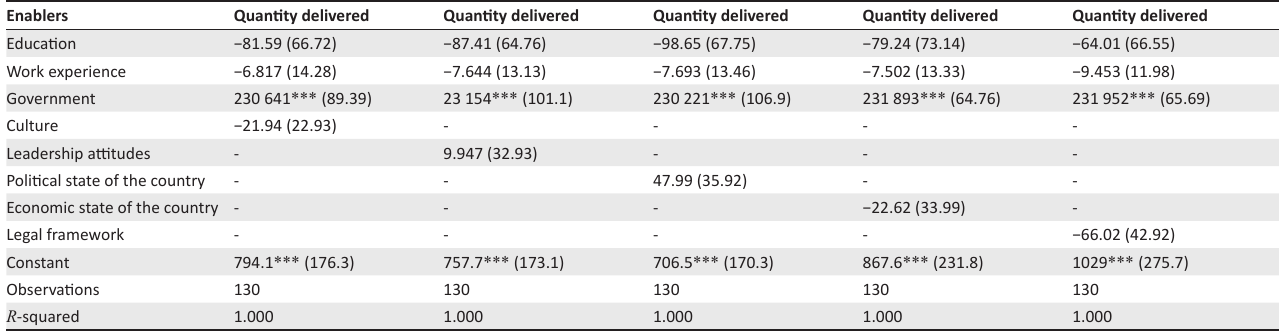
TABLE 6: The impact of enablers on quantity delivered. Enablers